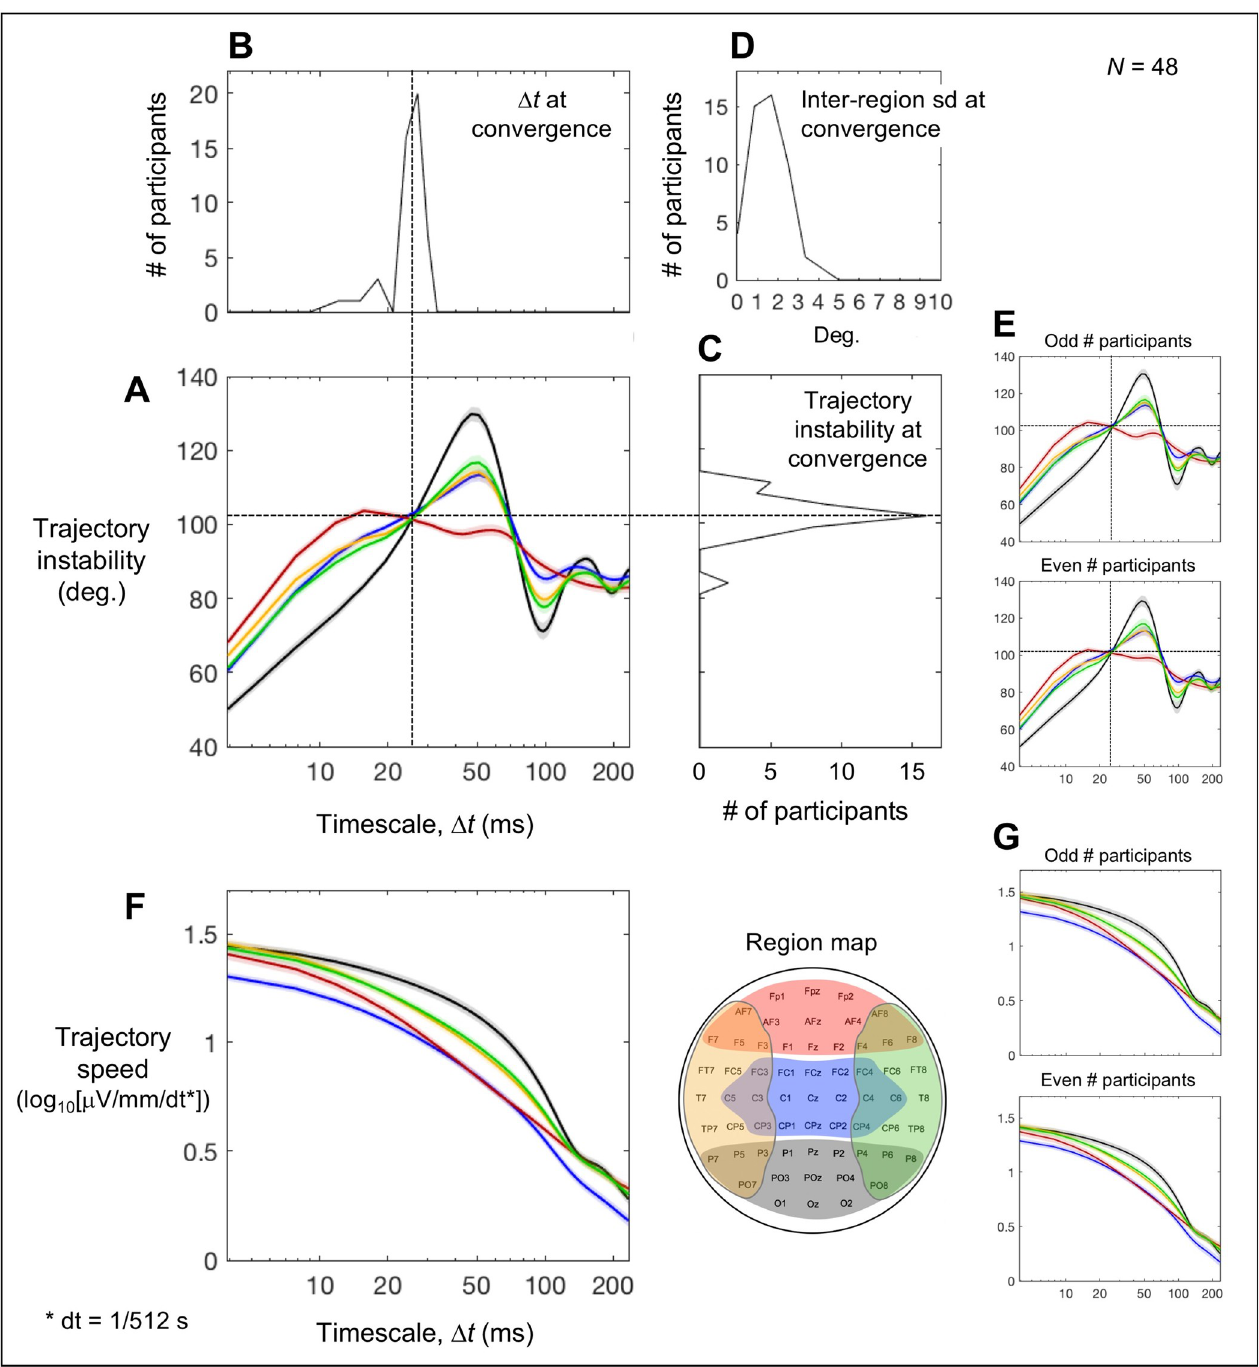
Fig 3. Trajectory instability and speed as a function of timescale Δ t . A-D. Trajectory instability. A. Time-averaged trajectory instability for the posterior (black), central (blue), anterior (red), left-lateral (orange), and right-lateral (green) regions as a function of Δ t . Notably, the five curves tightly converge at Δ t ~ 25 ms where the level of trajectory instability is ~100˚ (vertical and horizontal dashed lines). To illustrate the consistency of this convergence across participants, the cross-participant distributions (histograms) of the Δ t values and trajectory-instability levels at the convergence are shown in B and C , respectively. To illustrate the precision of convergence, the cross-participant distribution of the inter-region standard deviation (sd) of trajectory instability at the convergence is shown in D (mostly 1˚-2˚ and all less than 5˚). E. The time-averaged trajectory instability pattern in A shown separately for the odd and even numbered participants; the virtually identical patterns demonstrate statistical reliability. F. Time-averaged trajectory speed for the posterior (black), central (blue), anterior (red), left-lateral (orange), and right-lateral (green) regions as a function of Δ t . G. The time-averaged trajectory speed in F shown